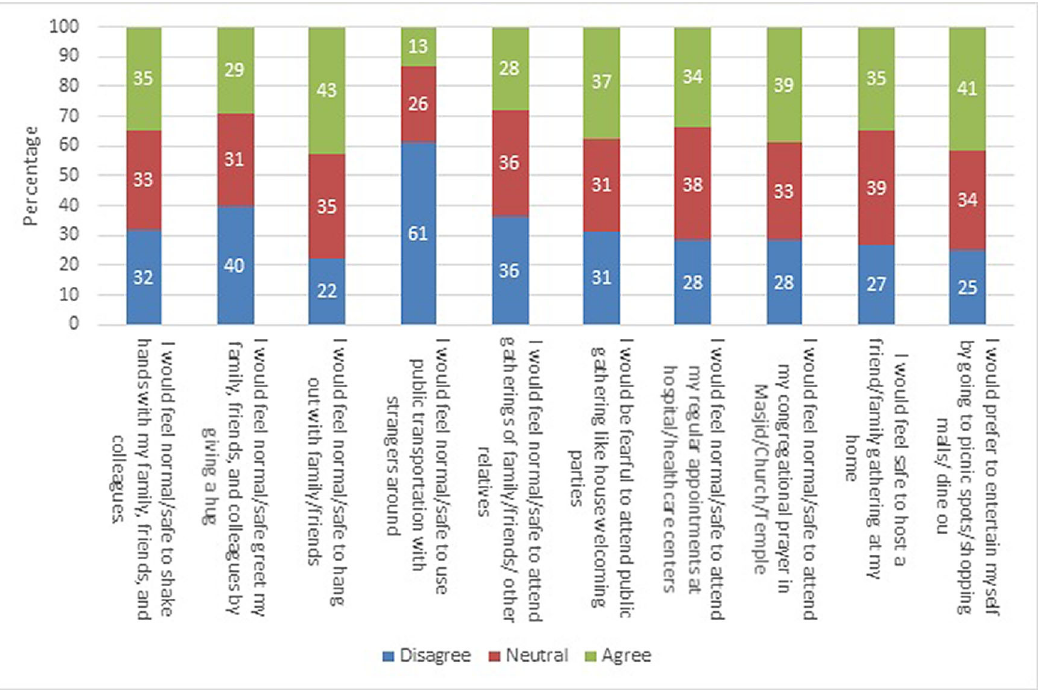
Table 1. Participant demographic characteristics and sense of safety in engaging in physical greetings after COVID-19. I would feel normal/safe shaking hands with my family, friends, and colleagues